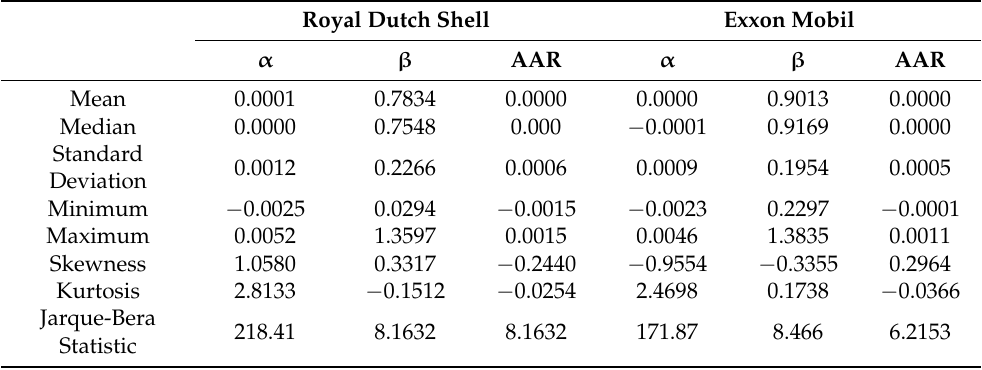
Table A2. Descriptive statistics of the alpha, beta and market and average abnormal returns regarding the induced seismicity in the Netherlands in the estimation window (day -100 to day -1), ( df = 422).